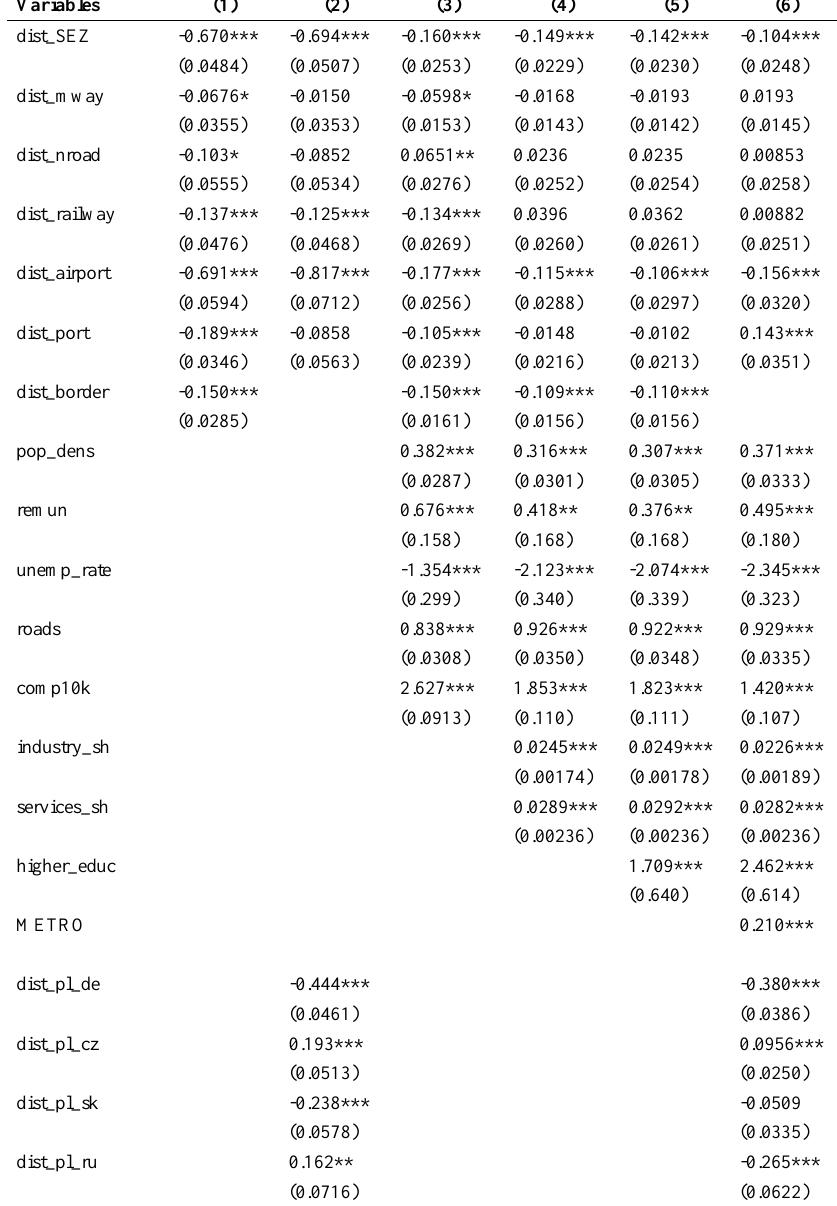
Table 3. Results of estimates of local FDI determinants in